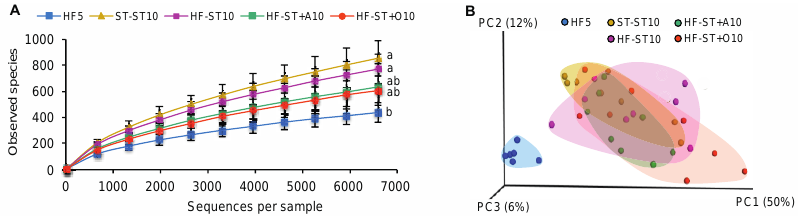
Figure 3. The effect of the diet shift and prebiotic supplementation on the cecal microbiota composition of overweight mice. Bacterial alpha diversity in cecum according to diet group ( A ); treatments with different superscript letters indicate significant differences (Bonferroni’s test, p < 0.05). Principal coordinate analysis (PCoA) plot of cecal communities ( B ). Weighted UniFrac distances were used to evaluate beta diversity.